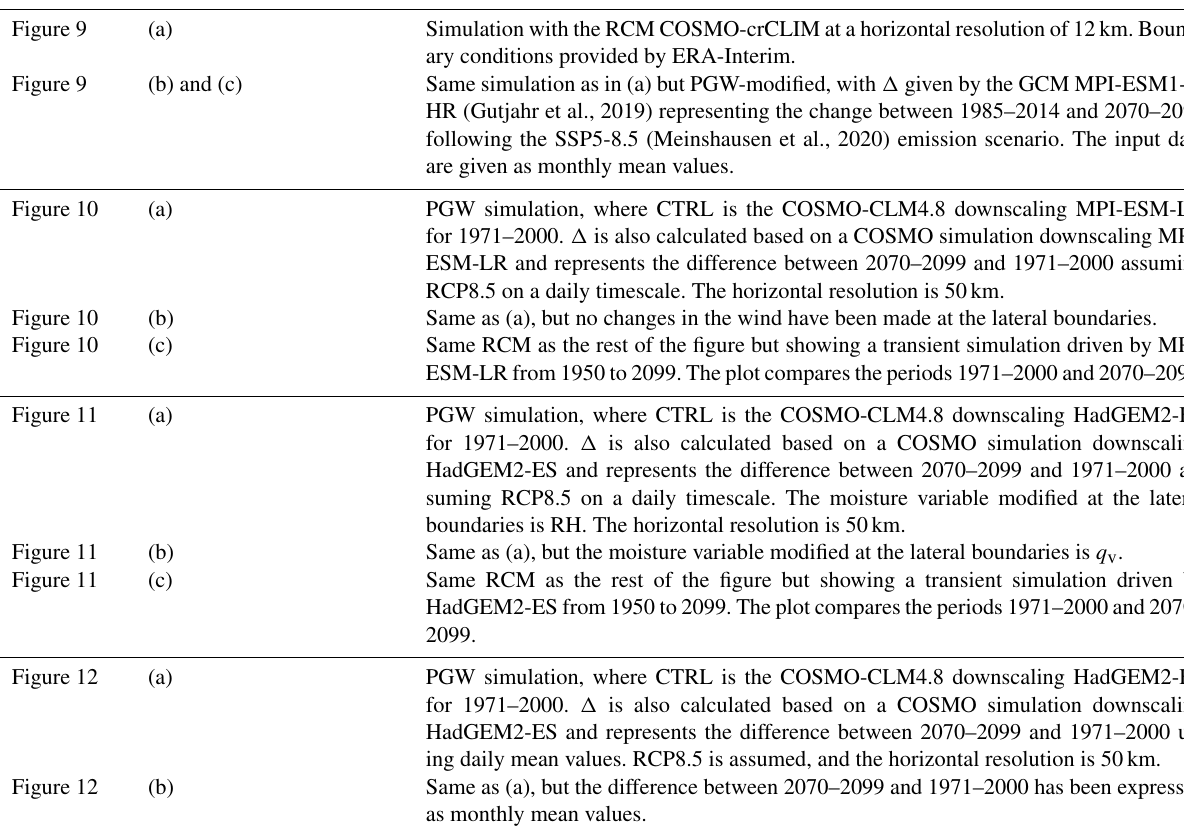
(a) Simulation with the RCM COSMO-crCLIM at a horizontal resolution of 12km. Bound- ary conditions provided by ERA-Interim. Figure 9 (b) and (c) Same simulation as in (a) but PGW-modified, with (cid:49) given by the GCM MPI-ESM1-2- HR (Gutjahr et al., 2019) representing the change between 1985–2014 and 2070–2099 following the SSP5-8.5 (Meinshausen et al., 2020) emission scenario. The input data are given as monthly mean values. Figure 10 (a) PGW simulation, where CTRL is the COSMO-CLM4.8 downscaling MPI-ESM-LR for 1971–2000. (cid:49) is also calculated based on a COSMO simulation downscaling MPI- ESM-LR and represents the difference between 2070–2099 and 1971–2000 assuming RCP8.5 on a daily timescale. The horizontal resolution is 50km. Figure 10 (b) Same as (a), but no changes in the wind have been made at the lateral boundaries. Figure 10 (c) Same RCM as the rest of the figure but showing a transient simulation driven by MPI- ESM-LR from 1950 to 2099. The plot compares the periods 1971–2000 and 2070–2099. Figure 11 (a) PGW simulation, where CTRL is the COSMO-CLM4.8 downscaling HadGEM2-ES for 1971–2000. (cid:49) is also calculated based on a COSMO simulation downscaling HadGEM2-ES and represents the difference between 2070–2099 and 1971–2000 as- suming RCP8.5 on a daily timescale. The moisture variable modified at the lateral boundaries is RH. The horizontal resolution is 50km. Figure 11 (b) Same as (a), but the moisture variable modified at the lateral boundaries is q v . Figure 11 (c) Same RCM as the rest of the figure but showing a transient simulation driven by HadGEM2-ES from 1950 to 2099. The plot compares the periods 1971–2000 and 2070– 2099. (a) PGW simulation, where CTRL is the COSMO-CLM4.8 downscaling HadGEM2-ES for 1971–2000. (cid:49) is also calculated based on a COSMO simulation downscaling HadGEM2-ES and represents the difference between 2070–2099 and 1971–2000 us- ing daily mean values. RCP8.5 is assumed, and the horizontal resolution is 50km. Figure 12 (b) Same as (a), but the difference between 2070–2099 and 1971–2000 has been expressed as monthly mean